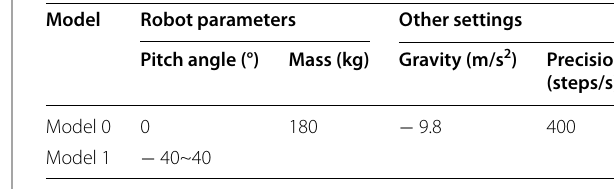
Table 5 Simulation